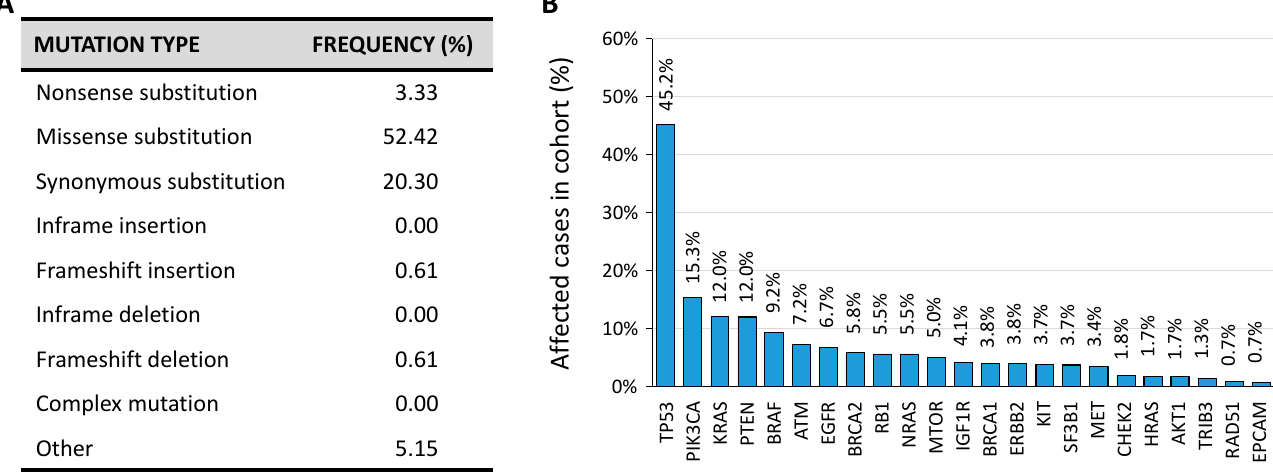
Figure 7. ( A ) Proportion of TRIB3 somatic mutations according to the COSMIC database (Tate et al., 2019). ( B ) Non-exhaustive distribution of most frequently mutated genes according to the TCGA Research Network (https://www.cancer.gov/tcga accessed on 6 January 2021).